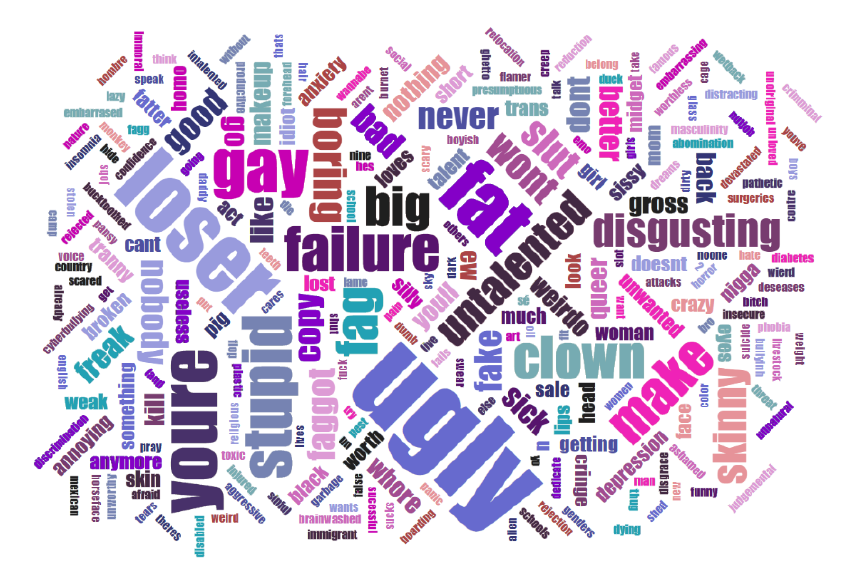
Figure 2. Self‐perceived insults by TikTokers in